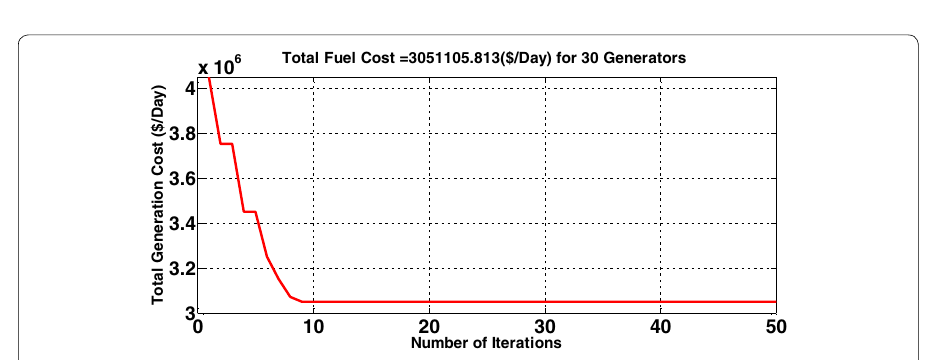
Fig. 9 Convergence graphs of test case